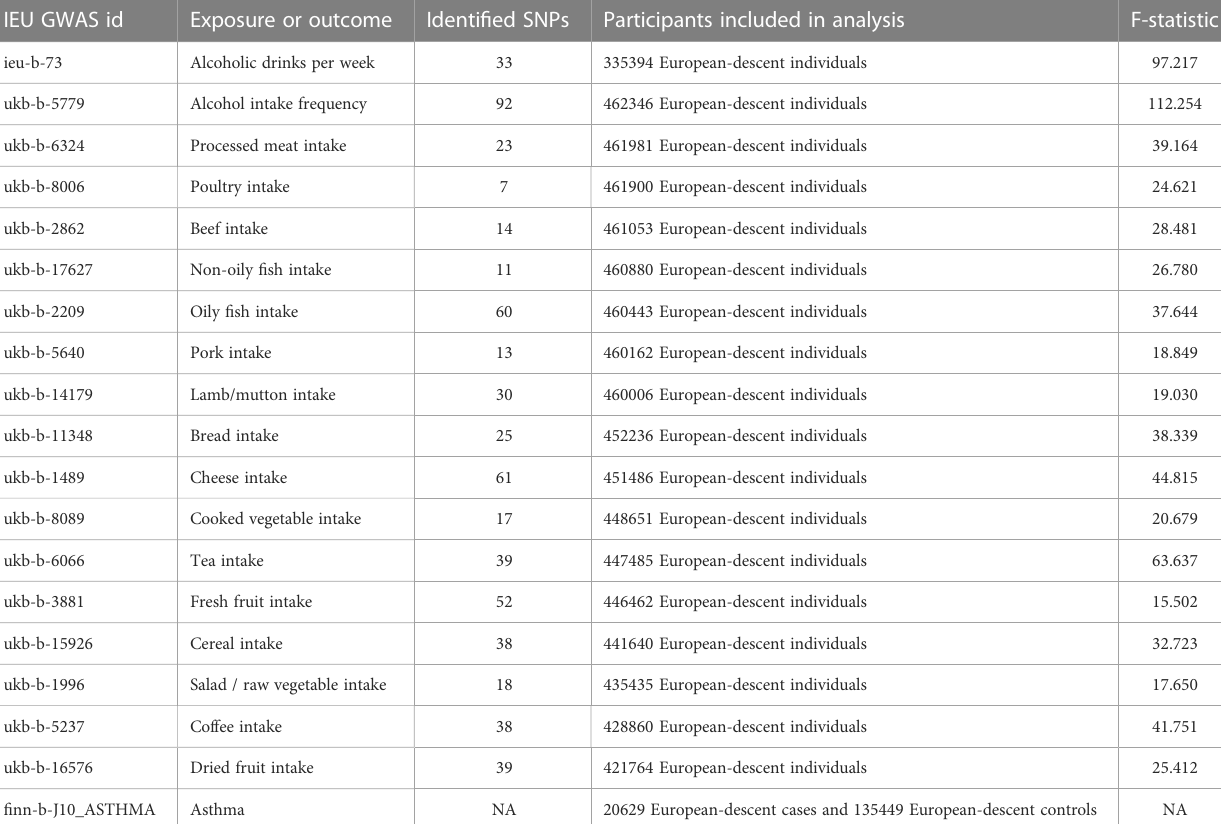
TABLE 1 Information of the exposures and outcome